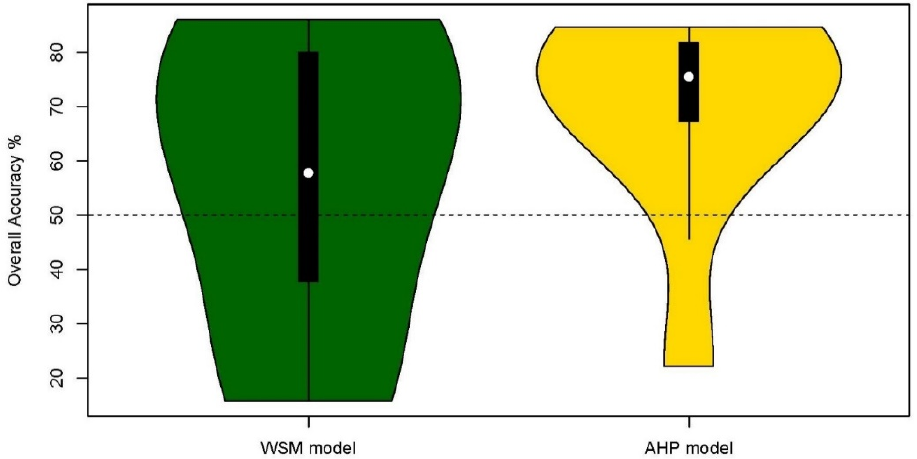
Figure 15. Overall accuracy using the mean of all buffer zones for the 21 dam sites for each of SWM and AHP models. ISPRS Int. J. Geo-Inf. 2020 , 9 , x FOR PEER REVIEW